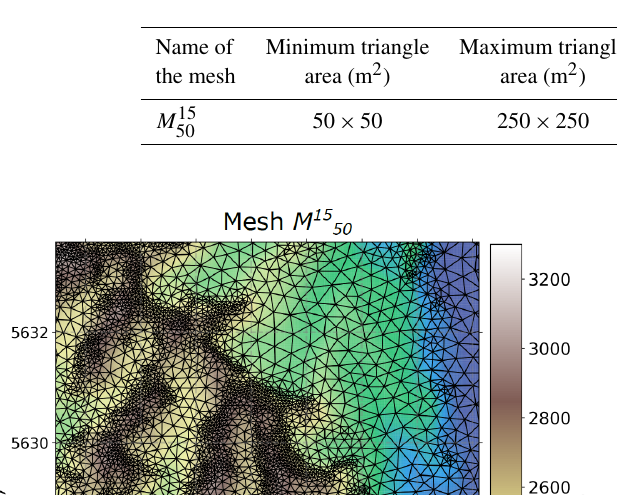
Table 1. Characteristics of the mesh used in this study. The vertical error corresponds the root-mean-square error to the underlying reference topographic raster.